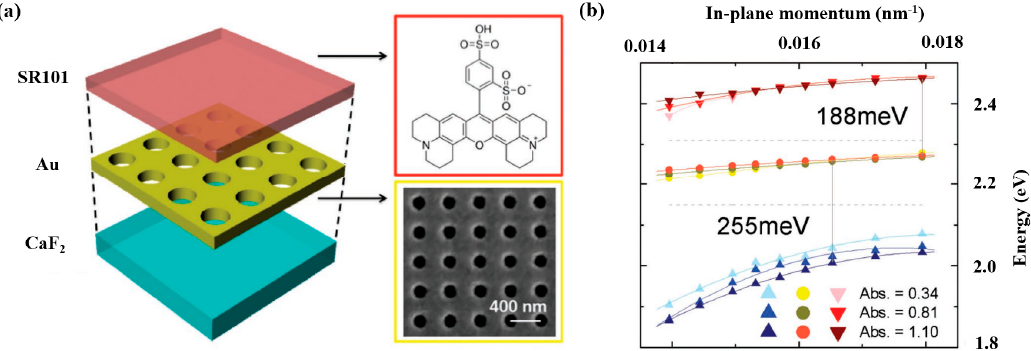
Figure 10. ( a ) Schematic of the hybrid exciton–plasmon system. The red upper part illustrates the chemical structure of SR 101 dyes, while an SEM image of the Au nanohole array is shown in the yellow box. ( b ) The energy dispersion curves, where the three bands were measured by changing the SR101 concentration. Adapted with permission from Ref. [133]. Copyright 2017 WILEY-VCH Verlag GmbH & Co. KGaA, Weinheim.